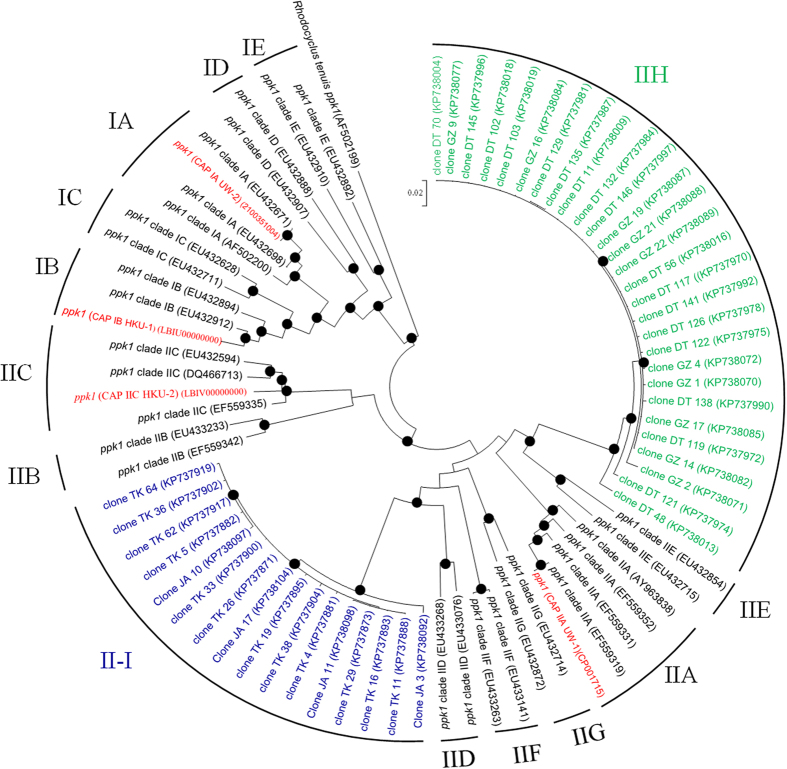
Phylogenetic tree indicating inferred relatedness of ppk1 genes from Accumulibacter by employing maximum likelihood method.The sequences produced by ppk1 gene clone libraries of CN-GZ-DT sludge sample were colored by green, and those of JP-A2O-TK sludge sample were colored by blue. The sequences in red are derived from draft genome sequences rather than clones. Black circles on node branches indicate >60% bootstrap support. The ppk1 gene of Rhodocyclus tenuis was adopted as the most closely related outgroup sequence.